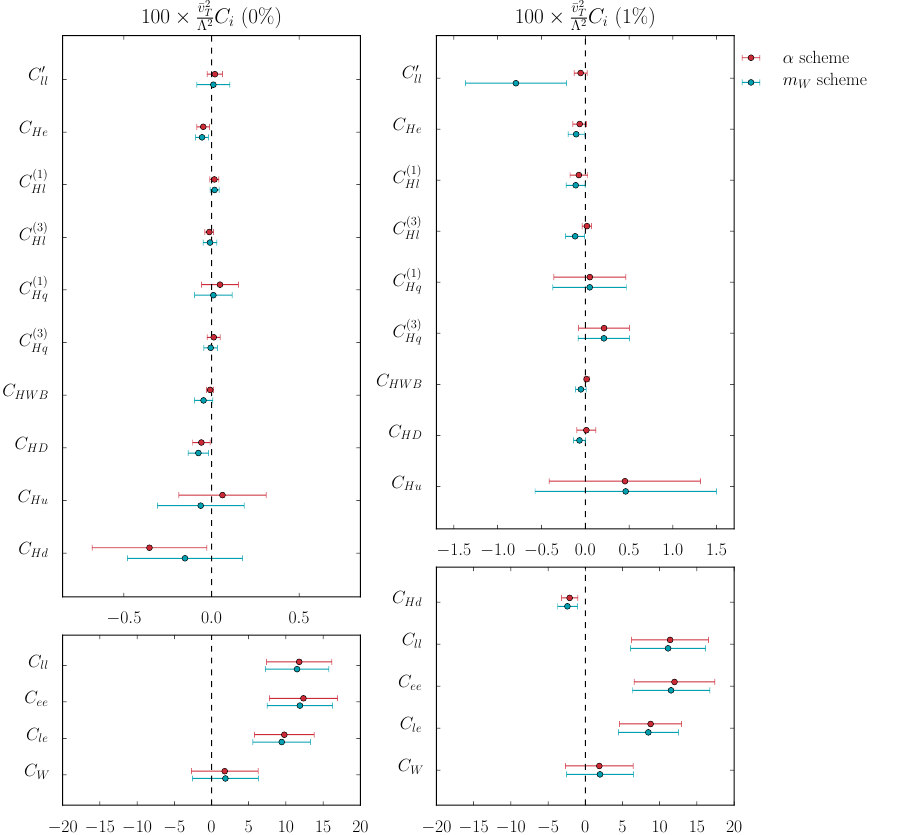
Figure 4 . Best (cid:12)t values of the Wilson coe(cid:14)cients (scaled by a factor 100) and corresponding 1 (cid:27) con(cid:12)dence regions obtained minimizing the (cid:1) (cid:31) 2 with one parameter at a time. Red (blue) (cid:6) points were obtained in the ^ (cid:11) ( ^ m W ) ; ^ m Z ; ^ G F input parameter scheme. The plot to the left f g has been obtained assuming (cid:1) SMEFT = 0, while the one to the right includes a theoretical error (cid:1) SMEFT = 0 : 01. Note that in the right plot the x axis has been scaled by a factor 2 and the coe(cid:14)cient C Hd has been moved to the lower panel: increasing the theoretical error enhances the 0 ;b pull of the anomaly compared to Z width data, and this relaxes by one order of magnitude FB A the bound on this